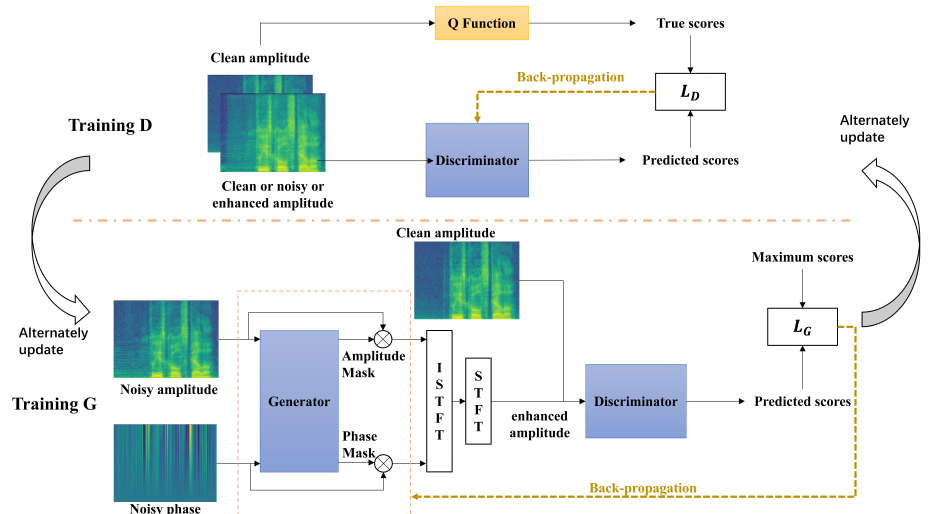
Figure 1. The overall framework of our system is shown here, with Training G and Training D representing the training process for the generator and discriminator respectively. They are updated alternately. Where Q Function is our target score, which we can choose to set as PESQ or STOI. STFT and ISTFT refer to Short Time Fourier Transform and Inverse Short Time Fourier Transform respectively. L G and L D denote the loss functions of the discriminator and the generator